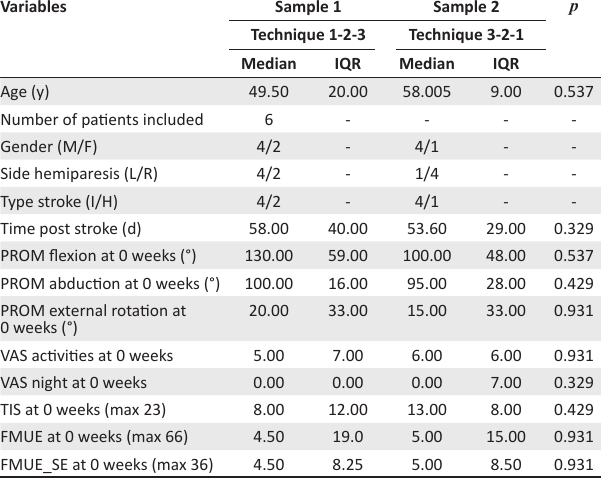
TABLE 1: Demographic data and baseline variables (median and interquartile range [IQR]) at the start of the intervention (week 0) ( n = 11). Variables